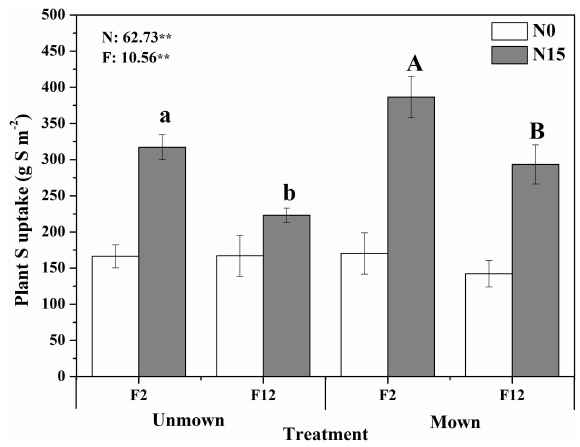
Figure 5. Effect of N addition intensity and frequency on plant S uptake by the dominant species of Leymus chinensis and Stipa grandis , with and without mowing (only plant samples in 0 and 15gNm − 2 yr − 1 were measured). F2 and F12 indicate low and high frequencies of N addition, respectively. Error bars indicate the stan- dard error. Effects of N addition intensity ( N ) and frequency ( F ) from three-way ANOVAs were labeled with ∗∗ and represent a sig- nificance level of 0.01. Different letters above the bars represent the significant difference among means for the N addition frequency (F2 vs. F12) at 15gNm − 2 yr − 1 (N15) without (lowercase letters) and with mowing (capital letters) separately. No significant differ- ence was detected (not labeled) between the two N frequencies at 0gNm − 2 yr − 1 for both mown and unmown treatments